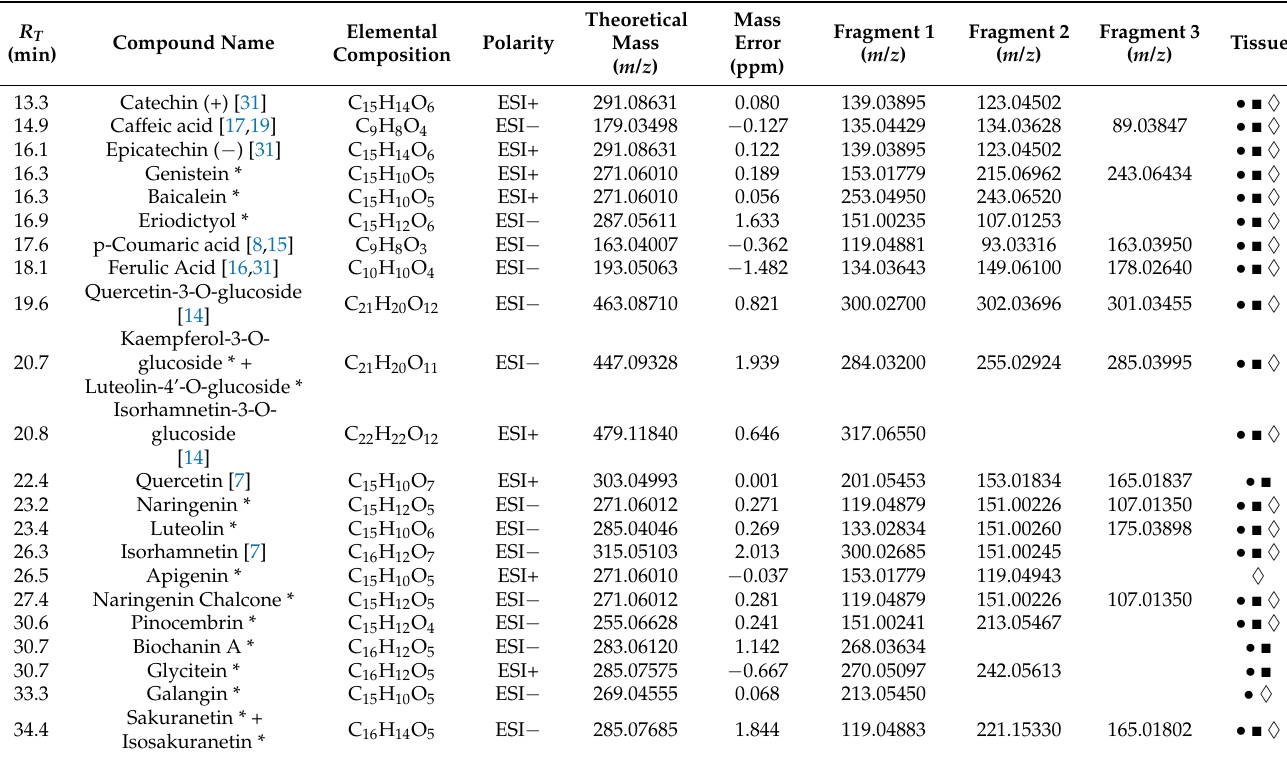
Table 1. Retention time ( R T ) and m/z ions for the identification and confirmation of the detected target compounds in P. oceanica roots ( • ), rhizomes ( (cid:4) ), and/or leaf ( ♦ ). Mass error corresponds to the smallest average mass error found among the three